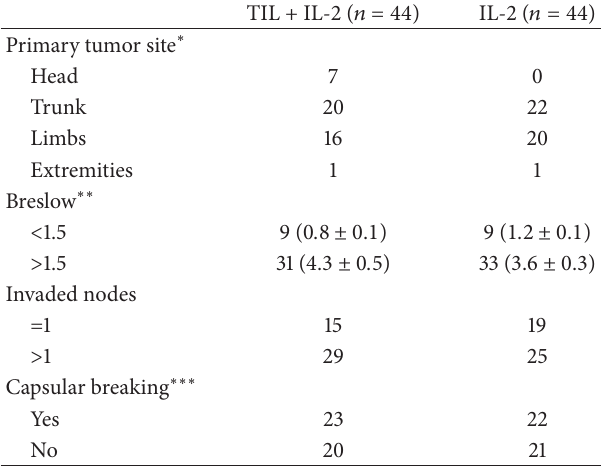
Figure3: Theoverall survivalratebetween theTIL+IL-2groupand IL-2 group was not significantly different ( 𝑃 = 0.39 ; log-rank test); 16.7 years of median followup.